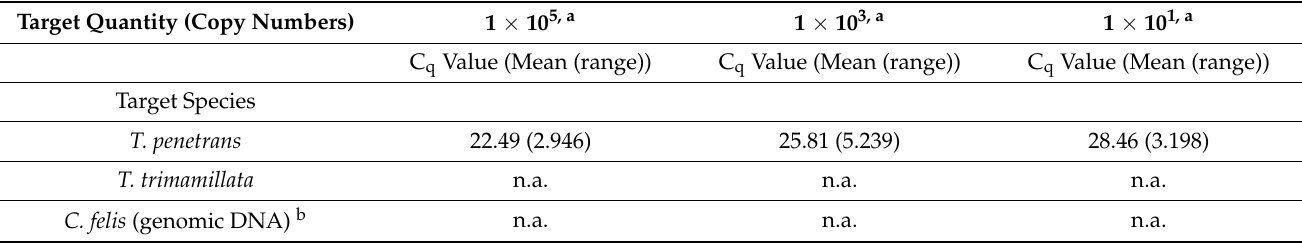
Table 3. Specificity of the Tunga-penetrans -specific PCR. Different amounts of plasmids containing the ITS-2 region of T. penetrans and Tunga trimamillata and genomic DNA from Ctenocephalides felis larvae were used as template for the T. penetrans -specific real-time